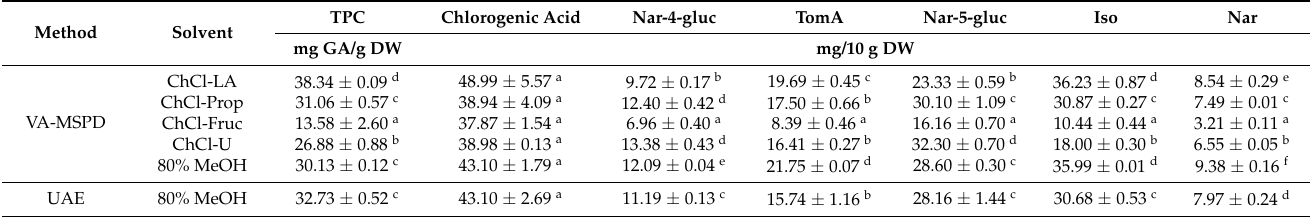
Table 1. Influence of NADES composition on VA-MSPD extraction efficiency of total phenolic content (TPC, mg GA/g DW) and major individual phenolic compounds (mg/10 mg DW) from H. arenarium inflorescences. Comparison with the reference method